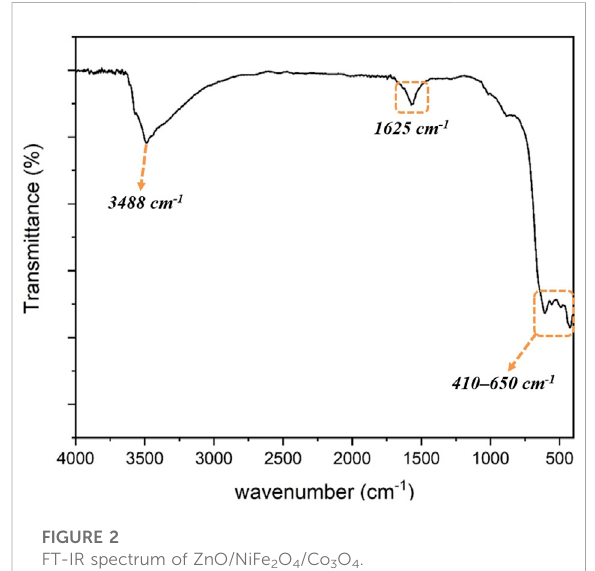
FIGURE 2 FT-IR spectrum of ZnO/NiFe 2 O 4 /Co 3 O 4 .